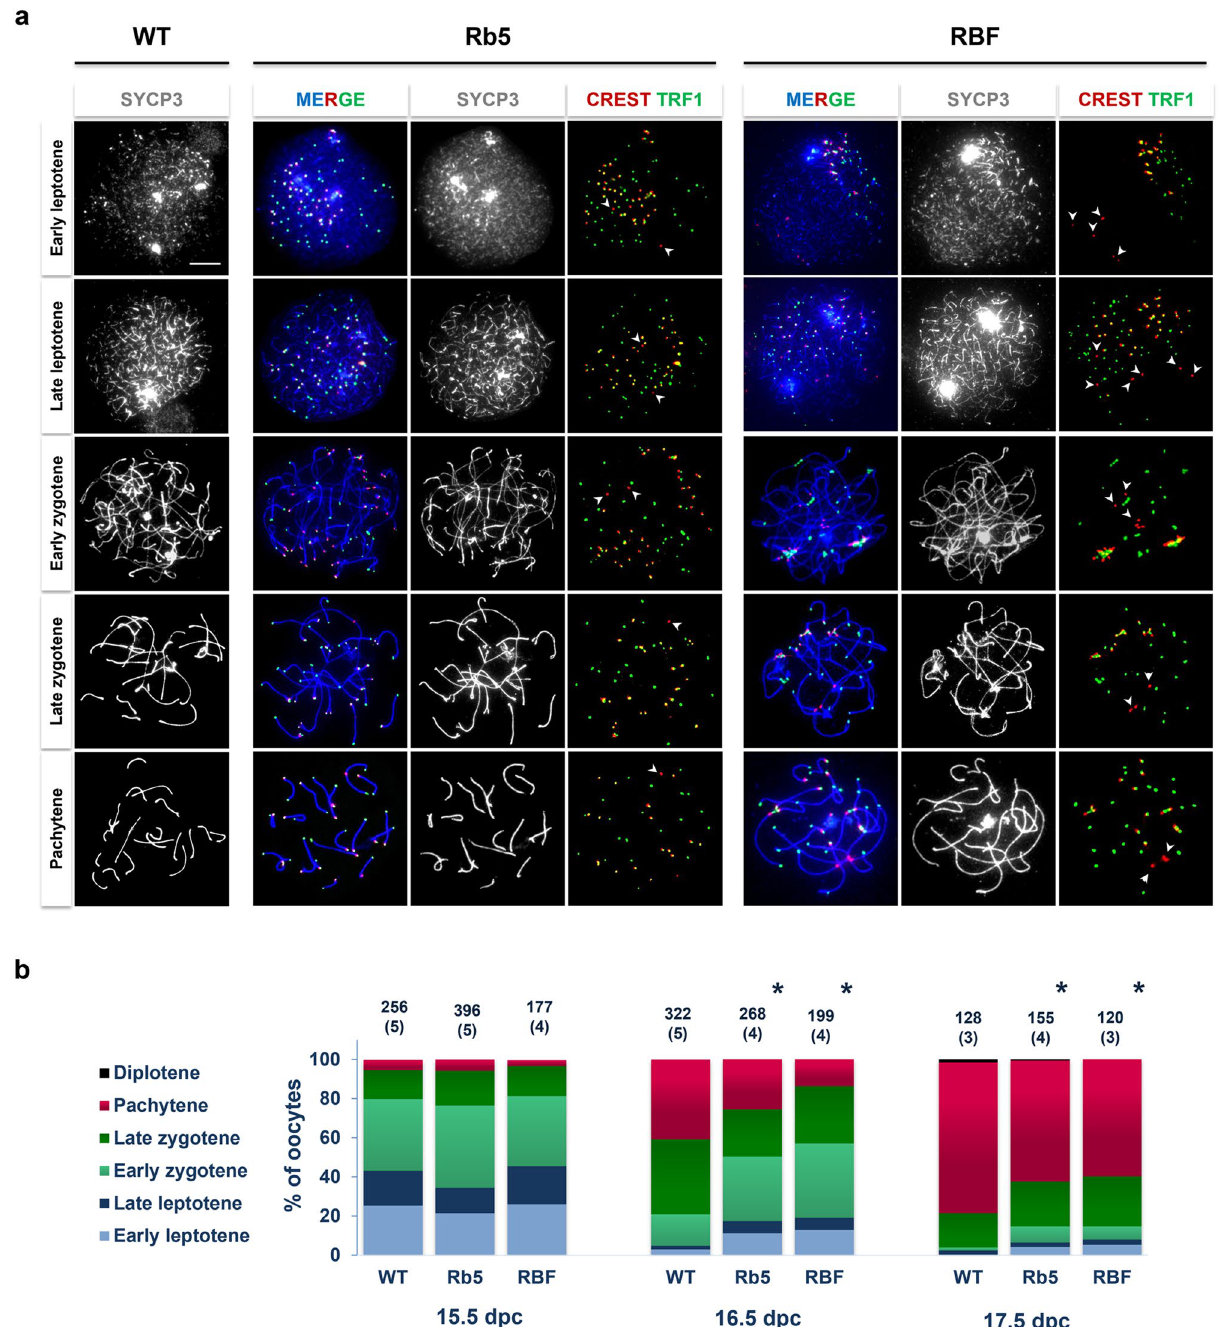
Figure 1. MPI progression in the oocytes of RbT-carrier and WT mouse ovaries at 15.5–17.5 dpc. ( a ) MPI substages identified by SYCP3 immunofluorescence (IF) staining. In Rb5 and RBF oocytes, RbT-centromeres (indicated by arrowheads) were identified by IF-staining of centromeres with CREST antibody (red) without adjacent telomeres with anti-TRF1 antibody (green). C- and D-telomeres were also distinguished by IF-staining of TRF1 with and without adjacent CREST staining, respectively. Scale bar 10 μm. ( b ) Percentages of oocytes at progressive MPI substages in the ovaries of each genotype. The number of examined oocytes and females (in parentheses) are given on the top of each column. *Significant difference between WT and Rb5 or RBF ovaries at P < 0.05 by χ 2